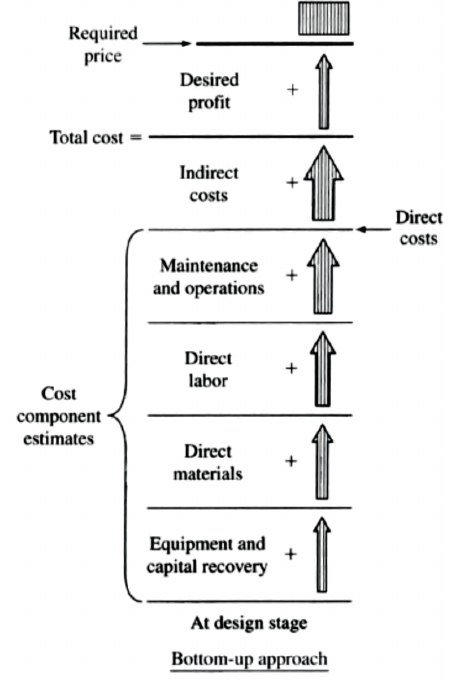
Fig. 3. Simplistic progression for the design-to-cost (bottom-up) approach (Blank and Tarquin,